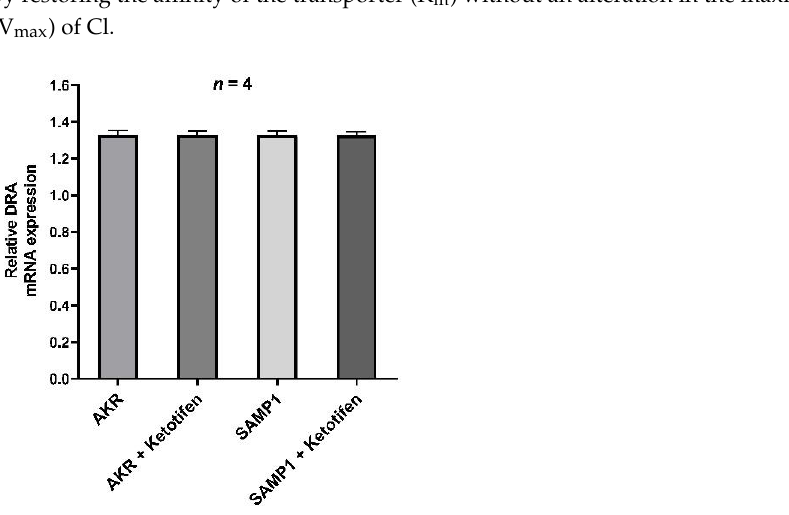
Figure 6. RT-qPCR analysis of DRA mRNA expression in intestinal villus cells isolated from ketotifen treated and untreated AKR, and SAMP1 mice. DRA mRNA expression remained unchanged in all experimental samples. The data obtained with β -actin was used to normalize the expression levels of DRA between individual